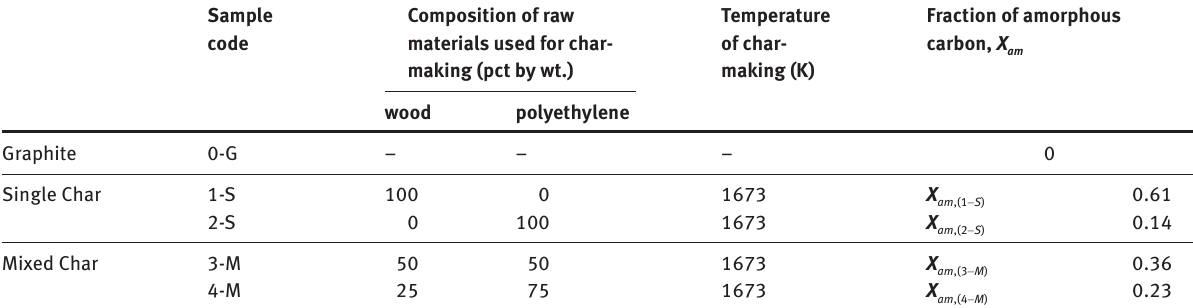
Table 1: Samples used for